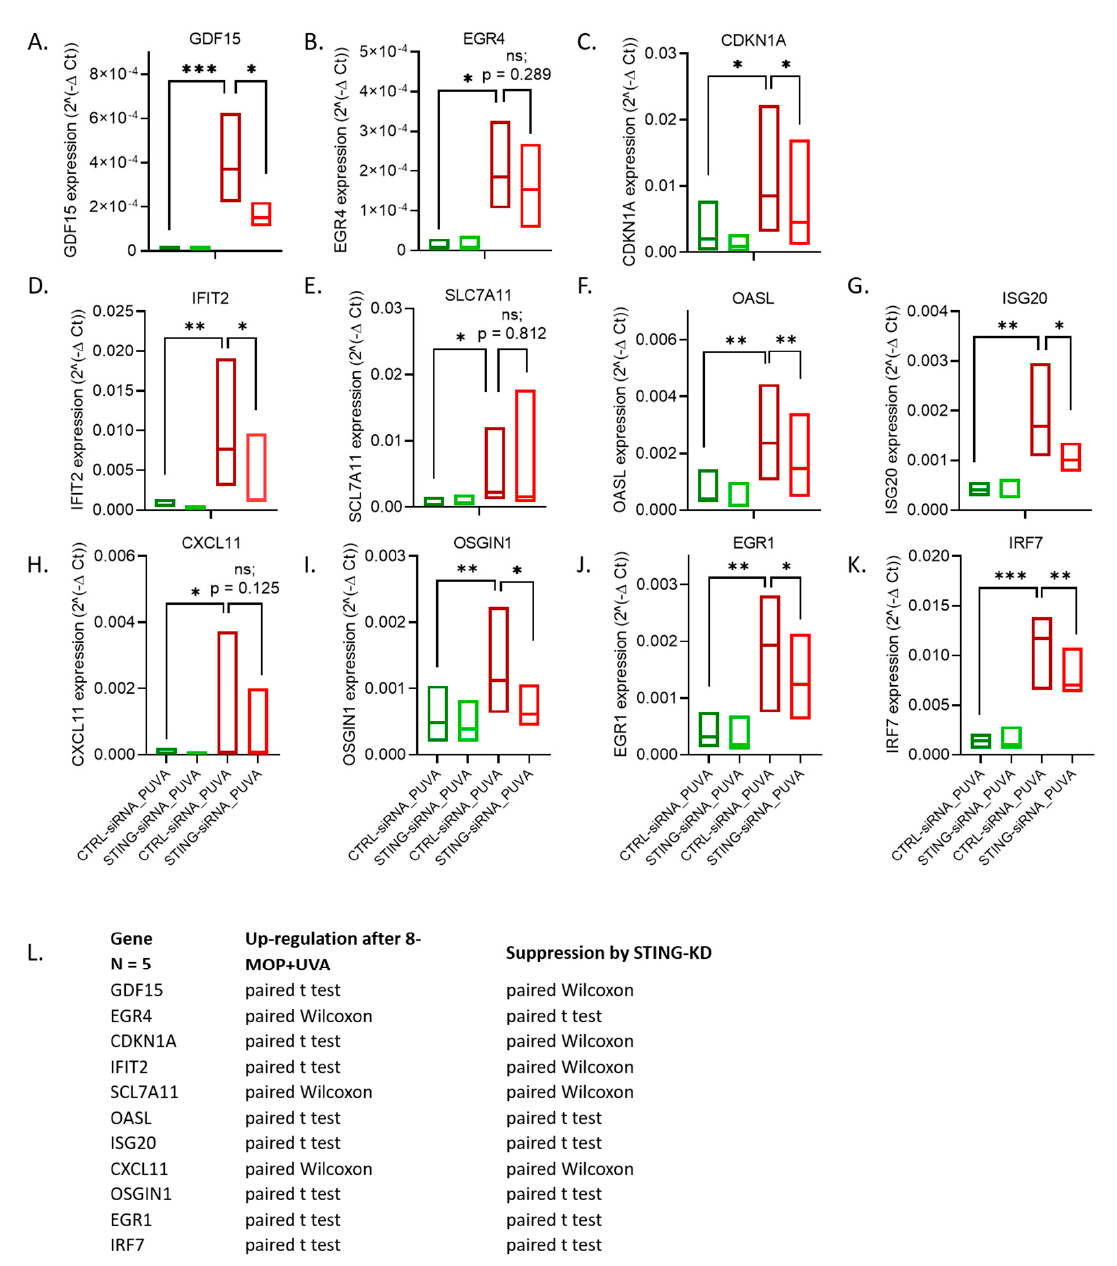
Figure 5. RT-qPCR verification of hits identified by RNA-Seq, i.e., transcripts upregulated by 8–MOP + UVA and remaining under STING control, largely confirms our findings. ( A – K ) Expression levels of each potential hit were measured in untreated (NIC) and subjected to 8–MOP + UVA (PUVA) treatment cells, transfected either with CTRL-siRNA or with STING-siRNA. ( L ) Statistical test used, chosen depending on the data distribution type (normal—paired t -test and skewed in at least one set—paired Wilcoxon test; see Methods). * p < 0.1, ** p < 0.05, *** p < 0.01, ns–not significant. STING knockdown efficiency: 82%.